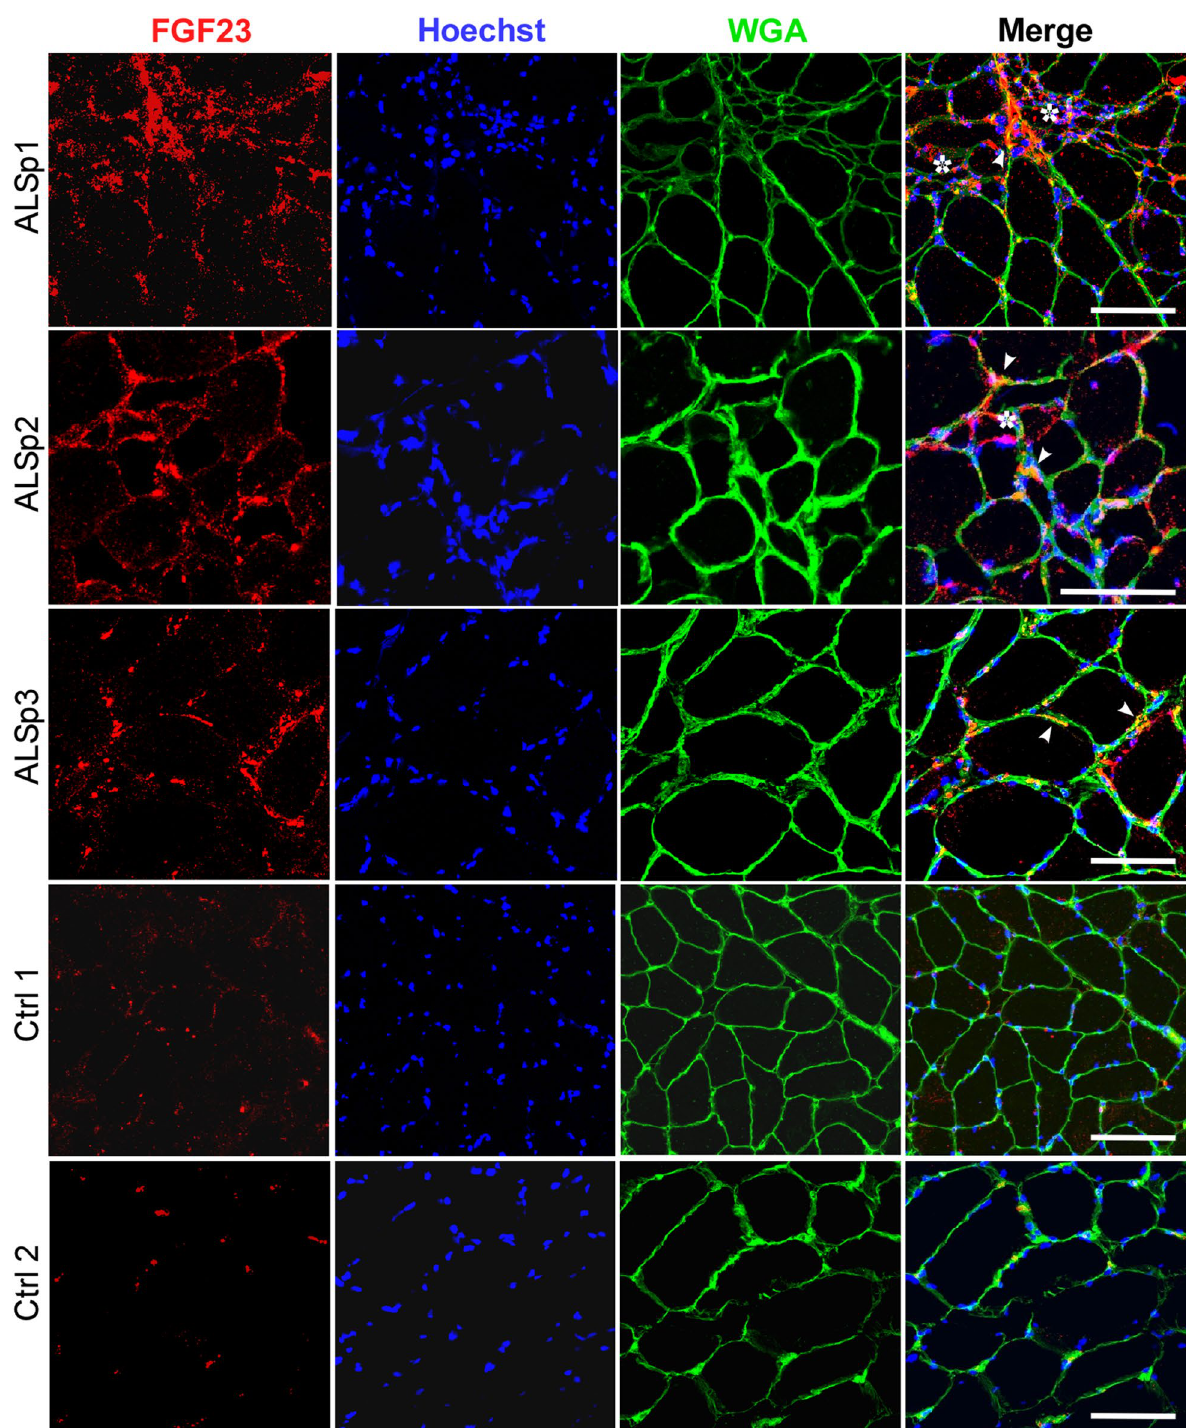
Figure 2. FGF23 protein is increased in ALS muscle tissue. Sections from 6 ALS and 4 normal muscle biopsy samples were immunostained with an anti-FGF23 antibody and counterstained with Hoechst and wheat germ agglutin (WGA). All 6 ALS patient samples but no control samples showed positive staining. Three of the ALS and two of the normal control sections are shown here. ALSp1 (deltoid), ALSp2 (vastus lateralis), ALSp3 (vastus lateralis), Ctrl1 (deltoid), Ctrl 2 (vastus lateralis). Asterisks highlight areas of grouped atrophy and arrowheads highlight several of the loci where FGF23 and WGA immunostaining colocalizes. Scale bars, 100